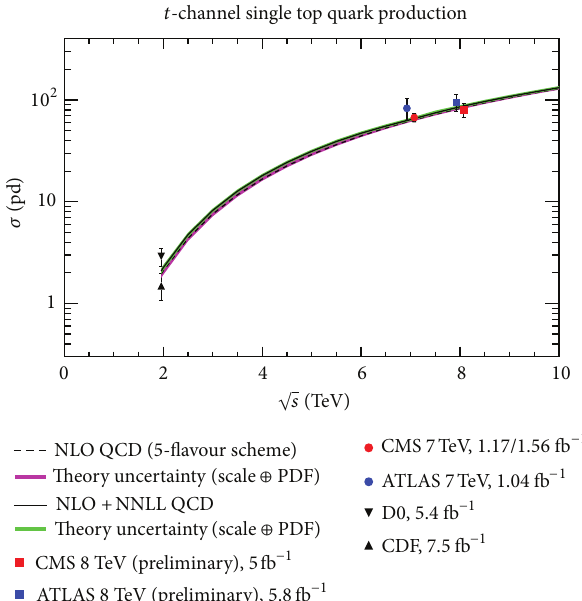
Figure 2: Single top cross-section in the 𝑡 -channel versus centre-of-mass energy, comparing the existing measurements at Tevatron and LHC with the QCD expectations computed at NLO with MCFM in the 5-flavour scheme [24] and at NLO + NNLL [25]. The error band (width of the curve) includes the uncertainty on the top mass, the PDF uncertainty estimated according to the HEPDATA recommendations [26], and the factorization and renormalization scales changed coherently by a factor two up and down.